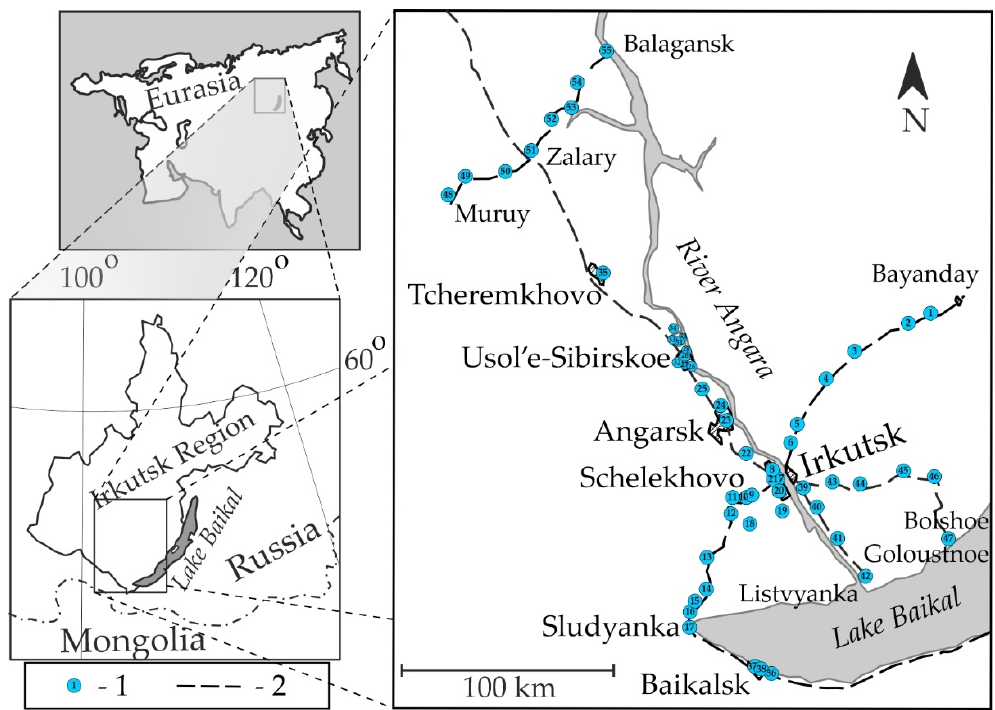
Figure 1. The scheme of snow sampling in the south of Irkutsk Region in 2021 (1—sampling site with the station number, 2—roads).